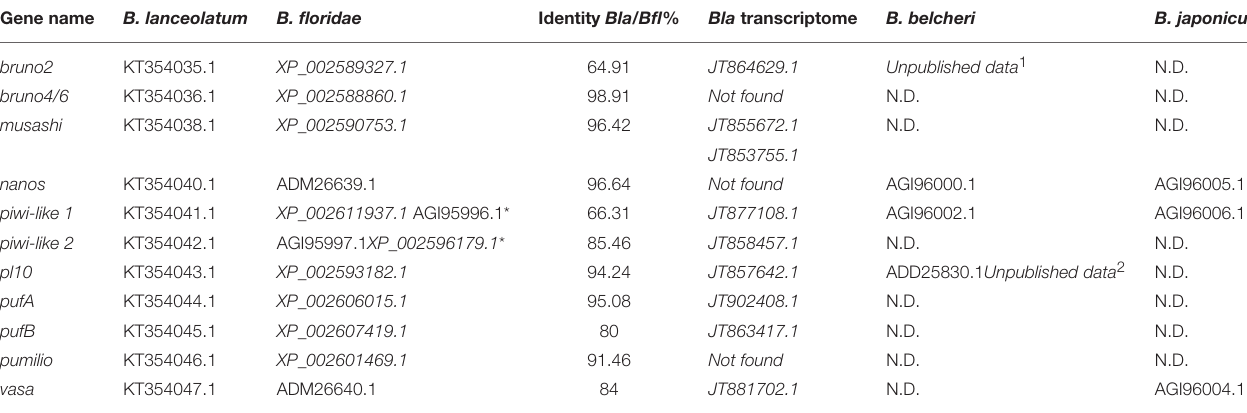
TABLE 1 | Genes cloned in this study and accession numbers for all identified sequences in Branchiostoma